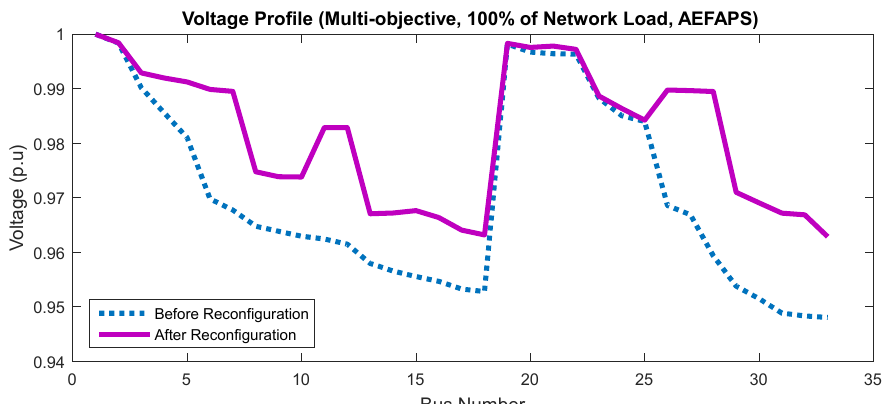
Figure 12. Voltage profile of a 33-bus network using AEFAPS before and after fuzzy many-criteria reconfiguration (nominal load).